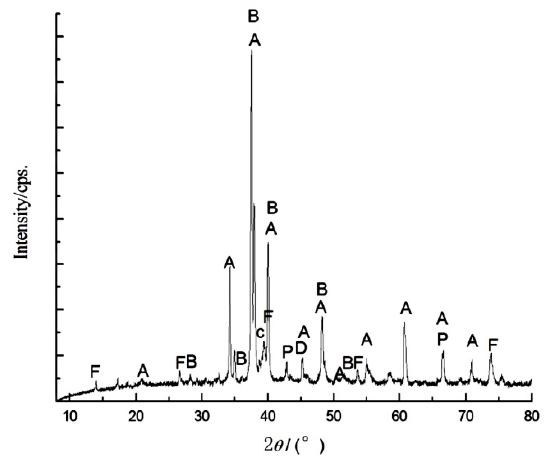
Figure 1. The XRD pattern of DM1 # (A—C 3 S, B—C 2 S, C—C 3 A, F—C 4 AF, D—CaO, P—MgO).